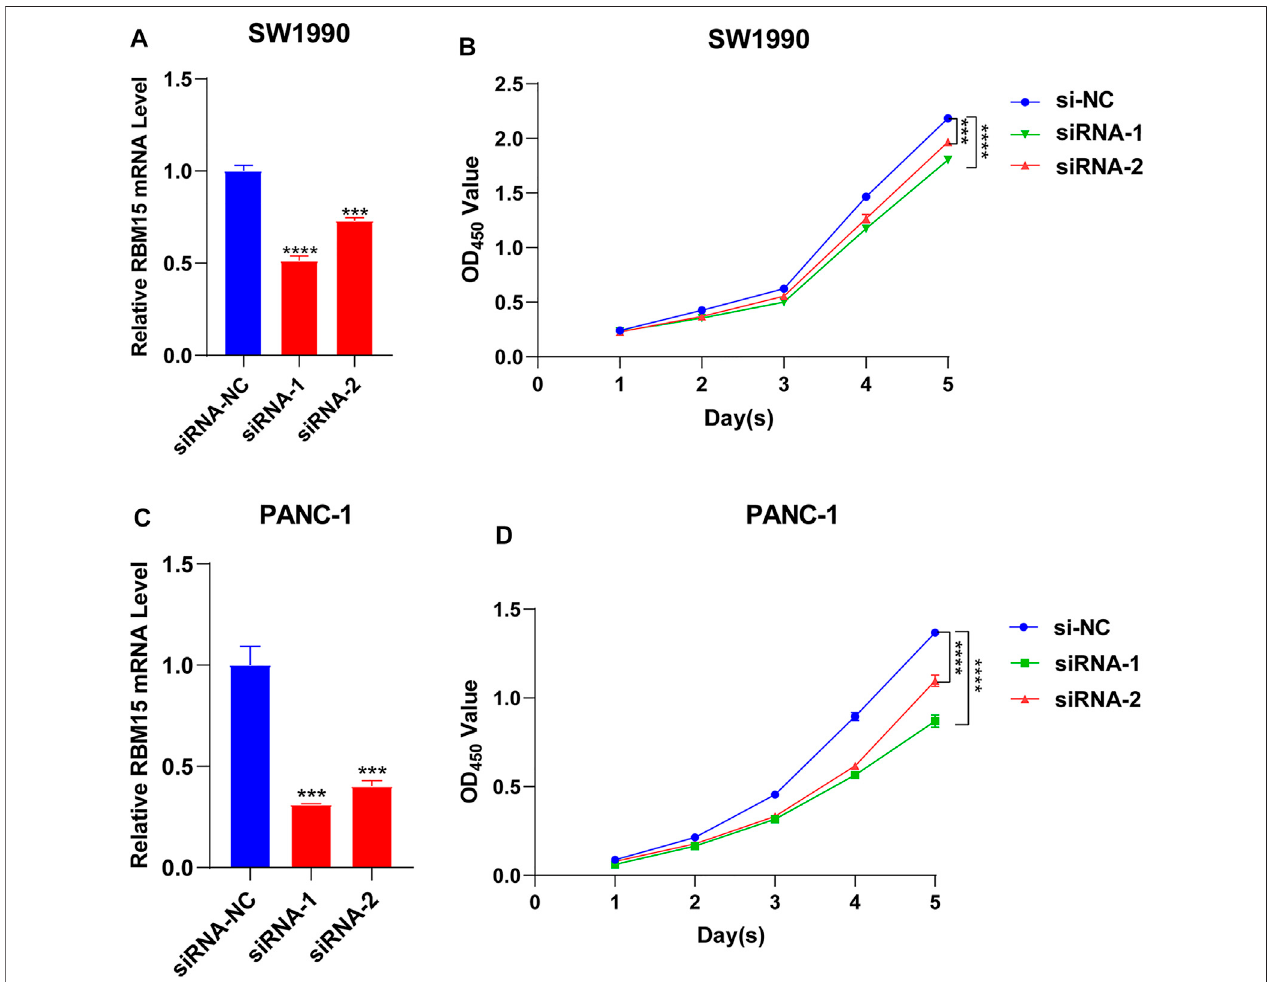
FIGURE 9 | Knockdown of RBM15 inhibited proliferation of pancreatic cancer cells. (A) The knockdown ef fi ciency of siRNA was detected by qRT-PCR in SW 1990. (B) CCK-8 showed thatknockdown ofRBM15 inhibited proliferation ofSW 1990. (C) The knockdown ef fi ciency ofsiRNA was detected byqRT-PCRin PANC-1. (D) CCK-8 showed that knockdown of RBM15 inhibited proliferation of